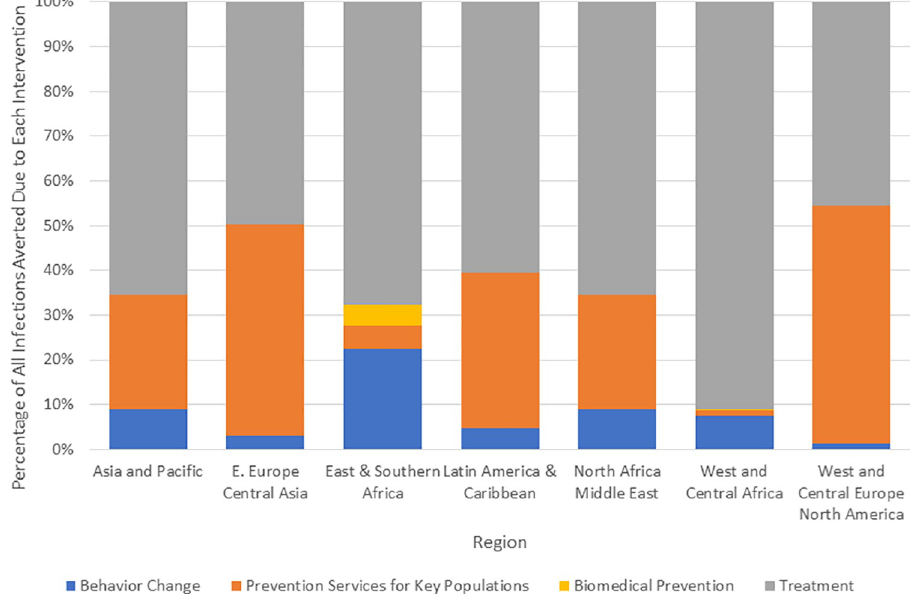
Fig 4. Contribution to reduction in new HIV infections by intervention